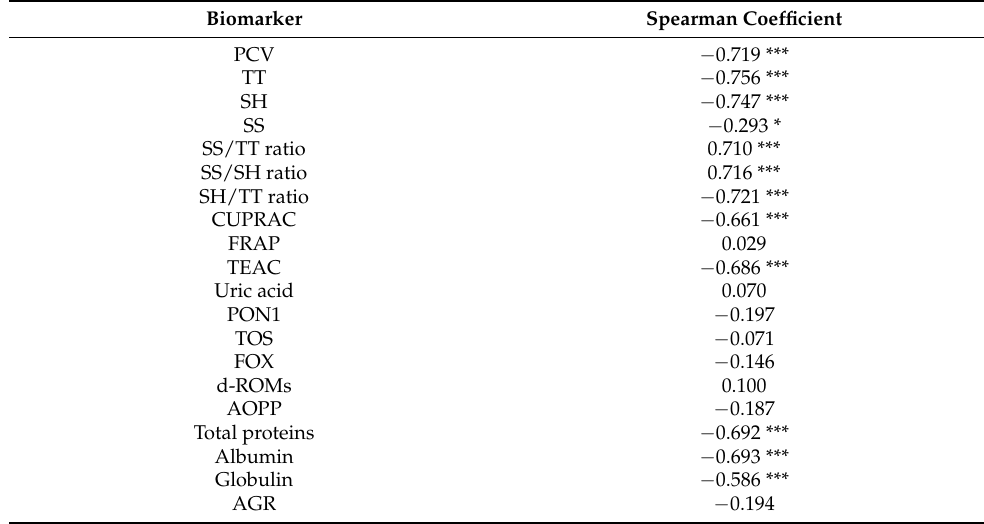
Table 1. Spearman correlation coefficients and significance between the different biomarkers stud- ied and the faecal worm egg counts (EPG) in lambs infected by gastrointestinal nematodes inserted in an integrated crop-livestock (ICL) system for 70 days.